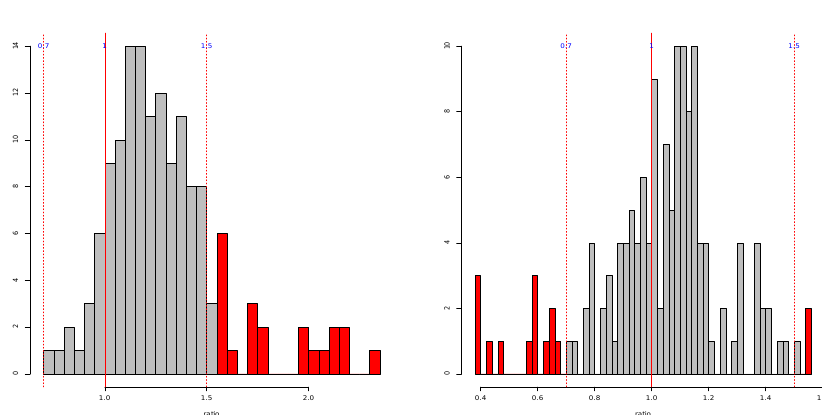
Figure A1. Histogram of Tables A1 and A2.